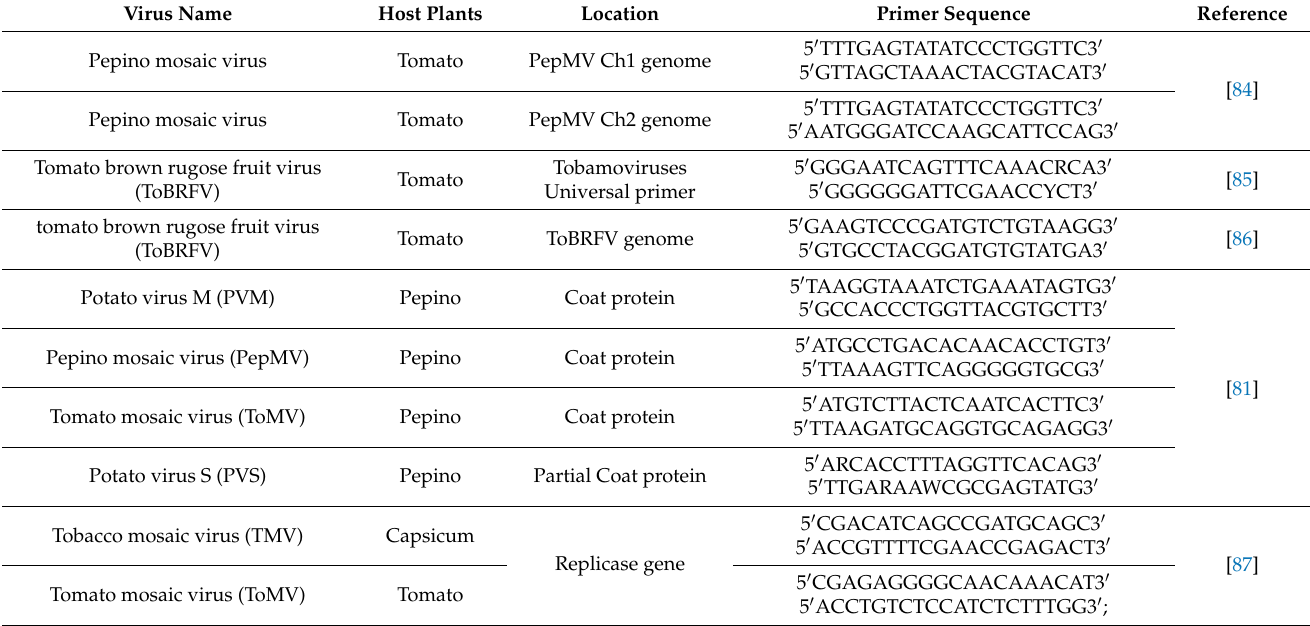
Table 2. List of conventional PCR and RT-PCR delineate primers targeting different conserved region of viral genome sequences for identifying viral